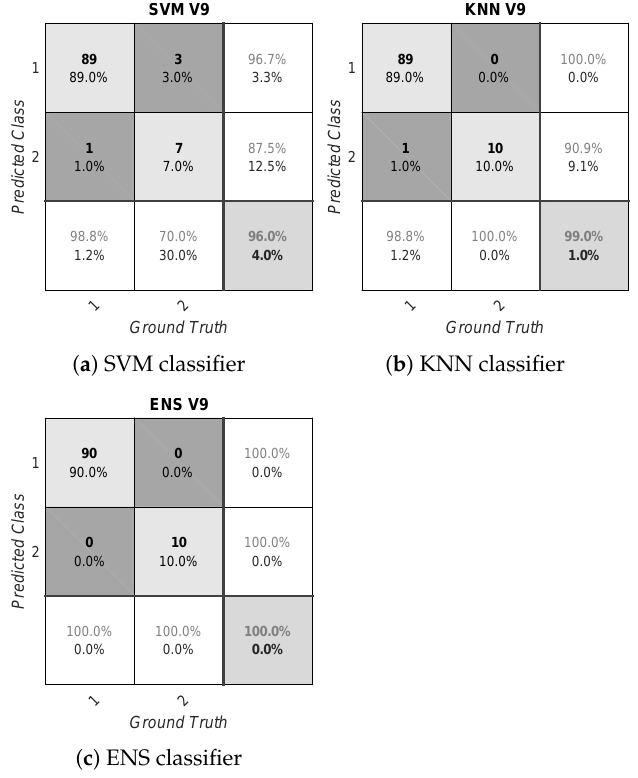
Figure A7. Confusion matrices for a subject-dependent model for V8.